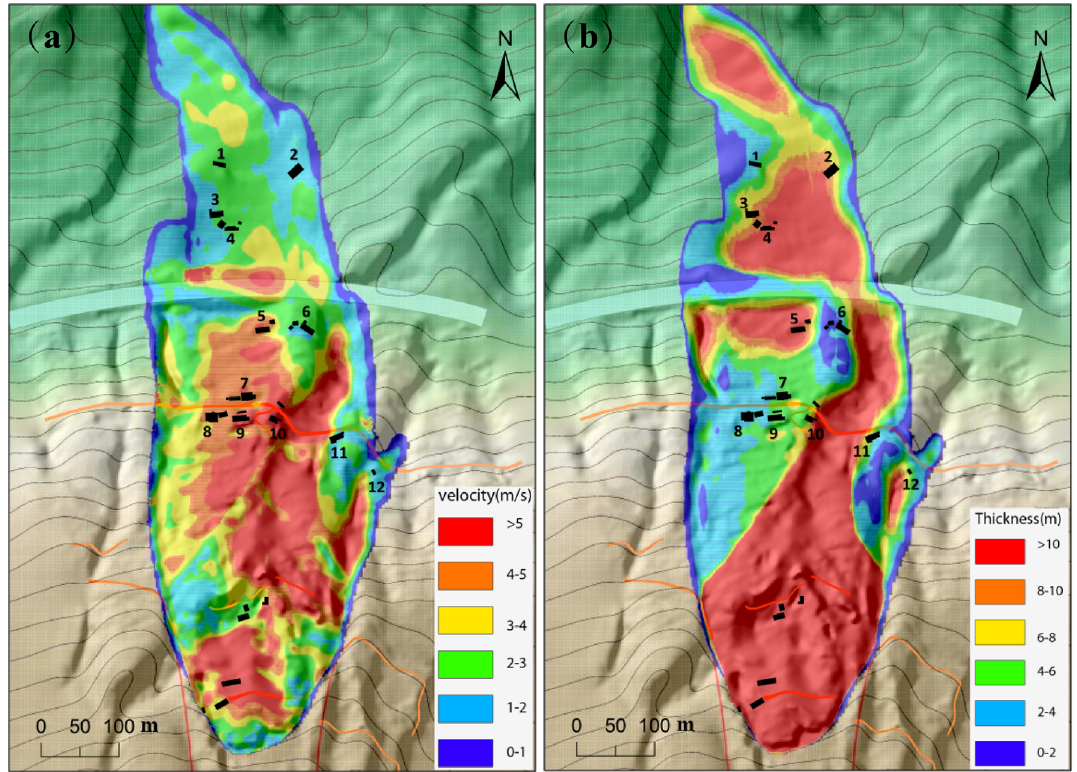
Fig. 10 Simulation results of the 2013 Sunjia landslide in Wanzhou County. a Map of the maximum landslide velocities. b Map of the maximum landslide thickness. The numbered black polygons mark the locations of the residential